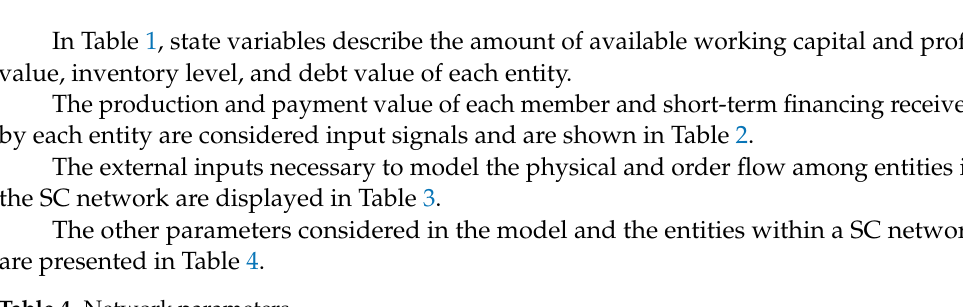
Table 4. Network